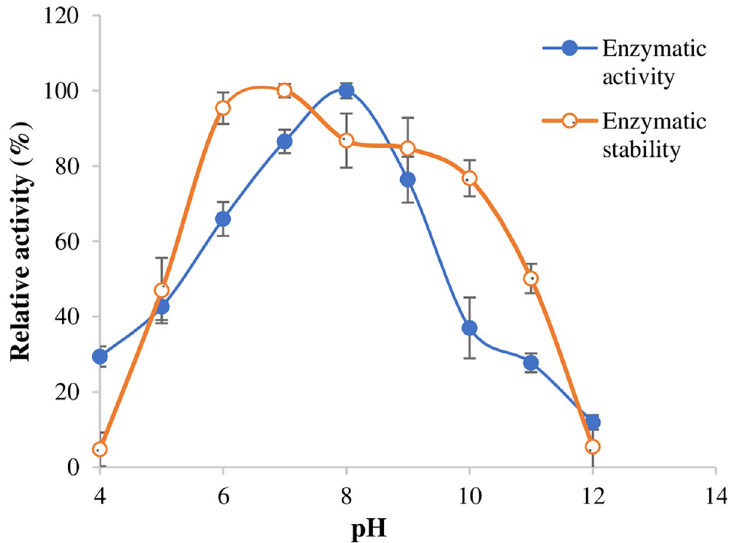
Fig 2. Relation of pH values to elastase activity and